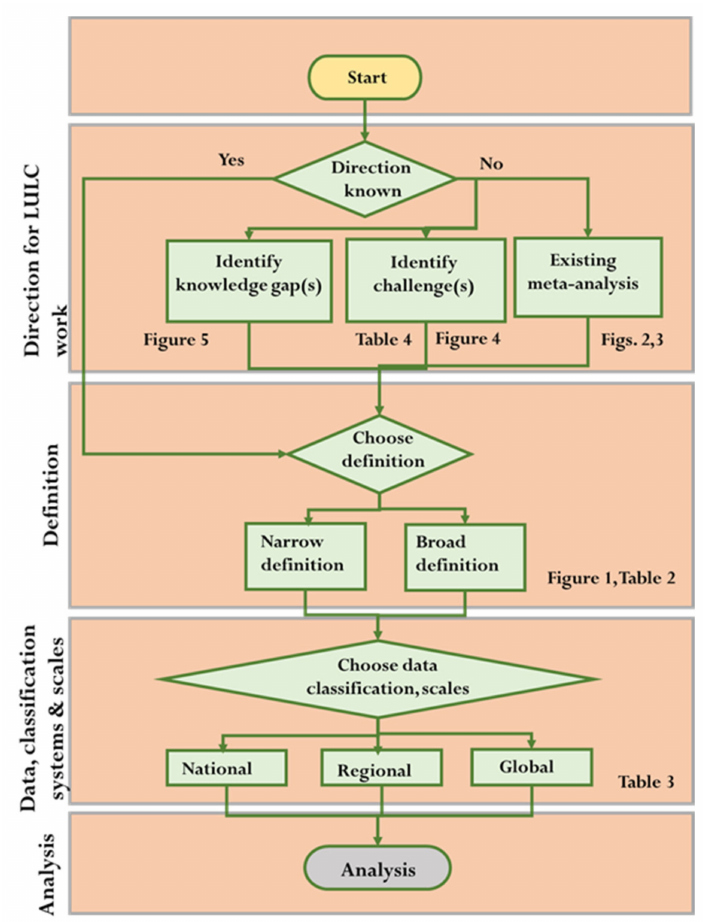
Figure 6. Flowchart of the synthesized research process, the procedure developed for a continuous flow of information from information acquisition to